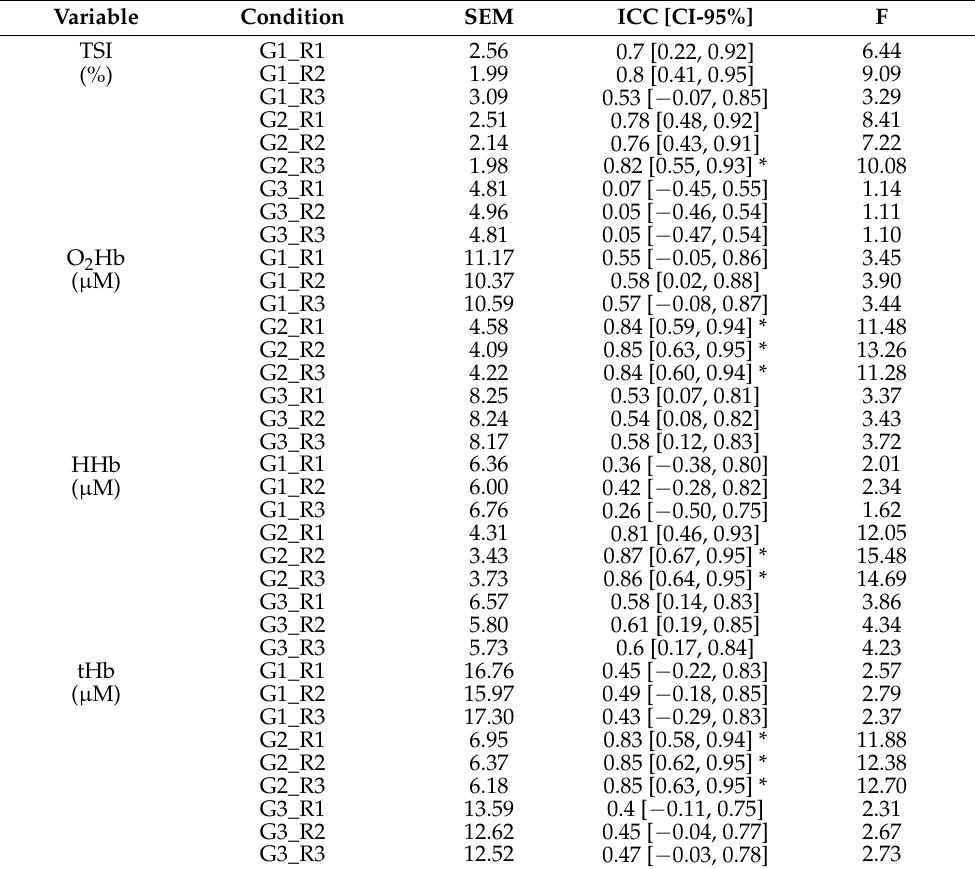
Table 11. Between-session reliability of maximums.